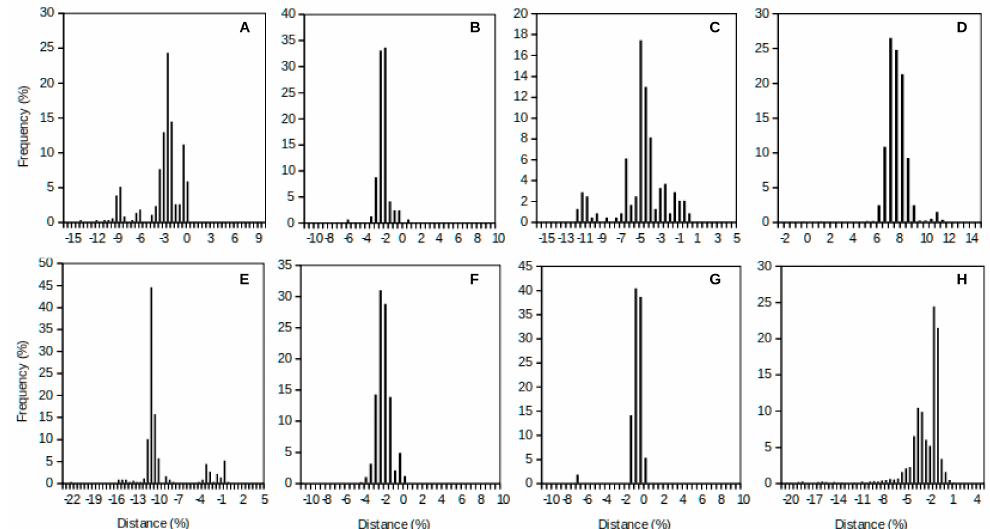
Figure 2. Eight additional examples showing the plots of the frequency distribution versus distance to the type strain of each species. The analysis was carried out for the species: Bacillus subtilis ( A ), Bacteroides fragilis ( B ), Clostridium botulinum ( C ), Helicobacter pylori ( D ), Rhizobium leguminosarum ( E ), Streptococcus pyogenes ( F ), Sulfolobus acidocaldarius ( G ), and Vibrio cholerae ( H ). The displacement of the main peak to one of the sides, away from zero distance, might suggest that a better reference (i.e., type strain) should be established. Distance represents the percentage of dissimilarity against the reference genome.